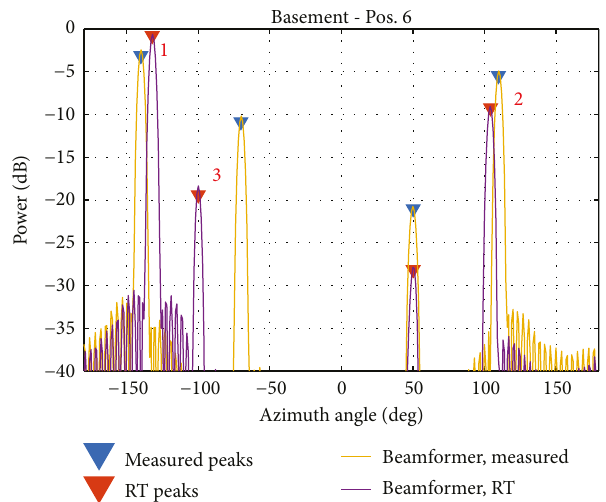
Figure 23: The identi fi ed 4 dominant paths in the measured and RT-simulated channels and the associated multiple beams for Tx position 6 in the basement